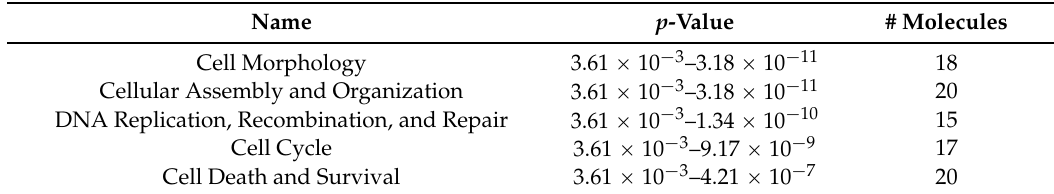
Table 6. Molecular and cellular functions for LAP1 interactors dataset.